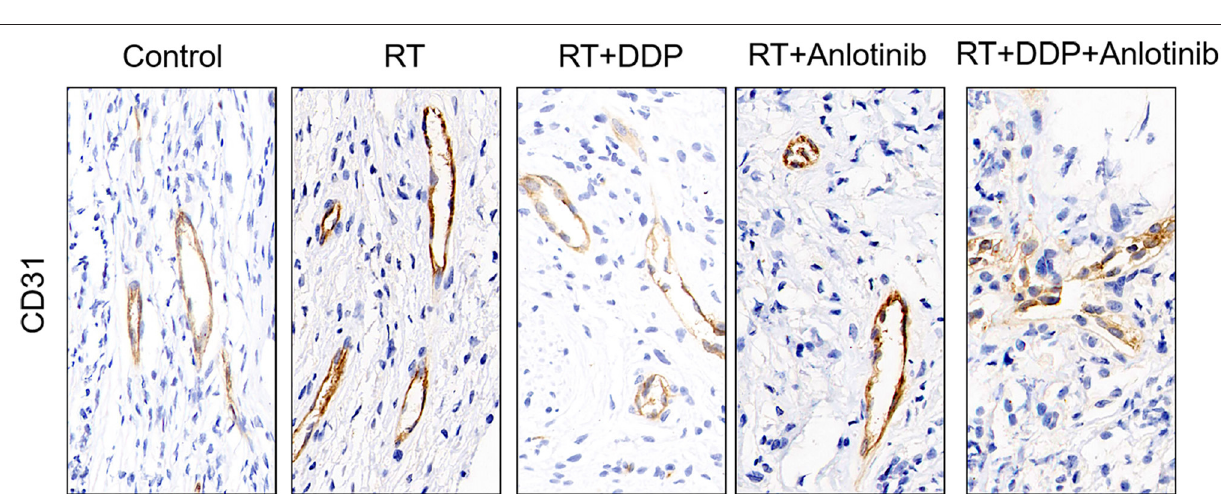
FIGURE 10 | The microvessel density (MVD) of different groups in patient-derived xenograft (PDX) models. The number of vessels were quantified by MVD, and the data are shown as mean ± SD . Compared with the control group, differences of MVD at various degrees existed in four treatment groups, and anlotinib combined with chemoradiation-treated group had the lowest MVD. RT, radiation therapy; DDP, cisplatin.